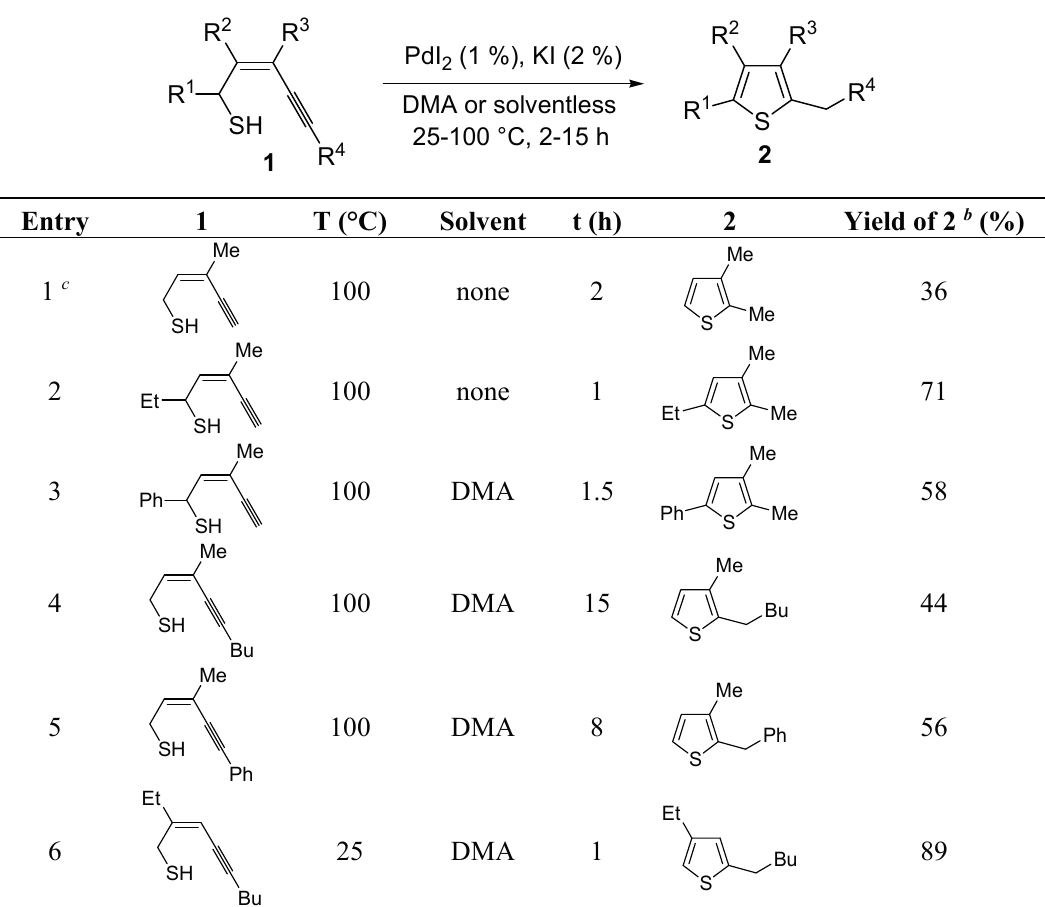
Table 1. PdI 2 /KI-catalyzed cycloisomerization of ( Z )-2-en-4-yne-1-thiols 1 to substituted thiophenes 2 a